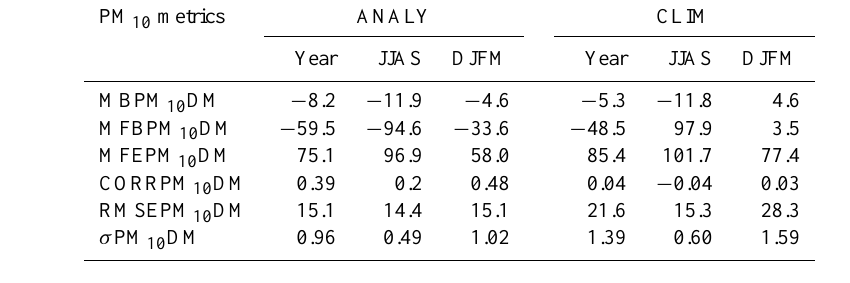
Table 9. Same as Table 6 for the PM 10 daily mean. The calculated statistics are MBPM 10 DM (µg m − 3 ), MFBPM 10 DM (%), MFEPM 10 DM